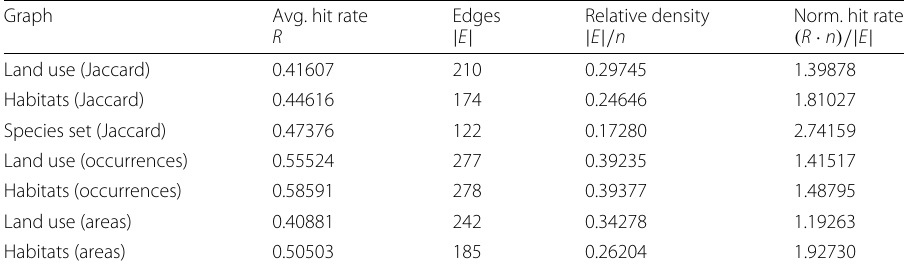
Table 4 Hit rates in similarity-based